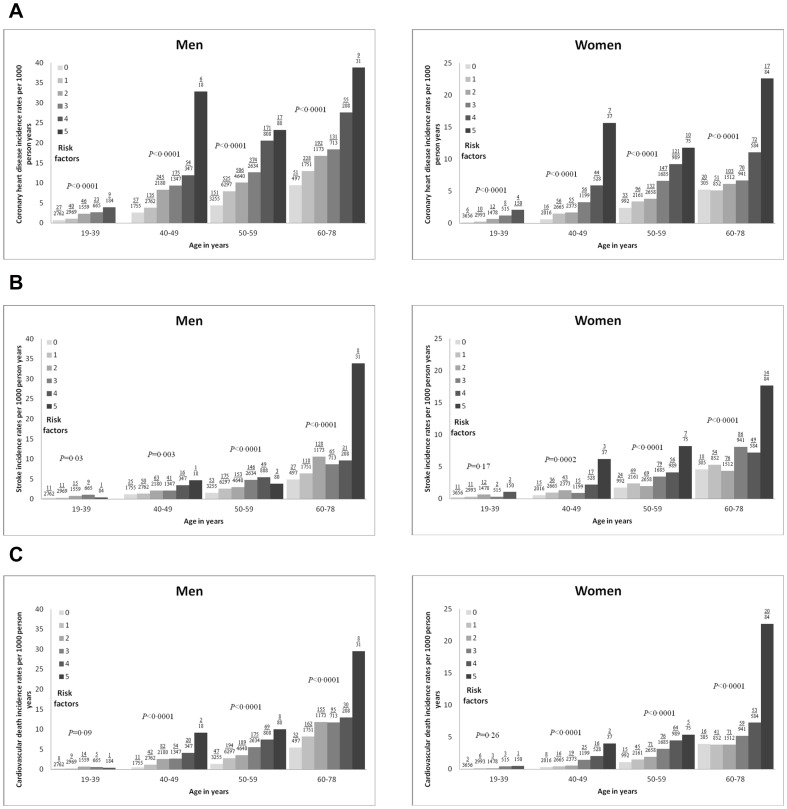
Age- and gender-specific incidence rates per 1000 person years for CVD with increasing number of risk factors.Risk factors refer to the components of the metabolic syndrome (MetS); and CVD, cardiovascular disease: (A) fatal and nonfatal CHD, (B) fatal and nonfatal stroke, and (C) cardiovascular death. Numbers above each bar indicate event/person. Overall trend with P<0.0001 for incidence rates with increasing number of MetS risk factors and age categories at baseline. Within each age group, the reported P values indicate significant differences in incidence rates with rising number of MetS risk factors, except in men (for CVD) and women (for stroke and CVD) below age 40 years.